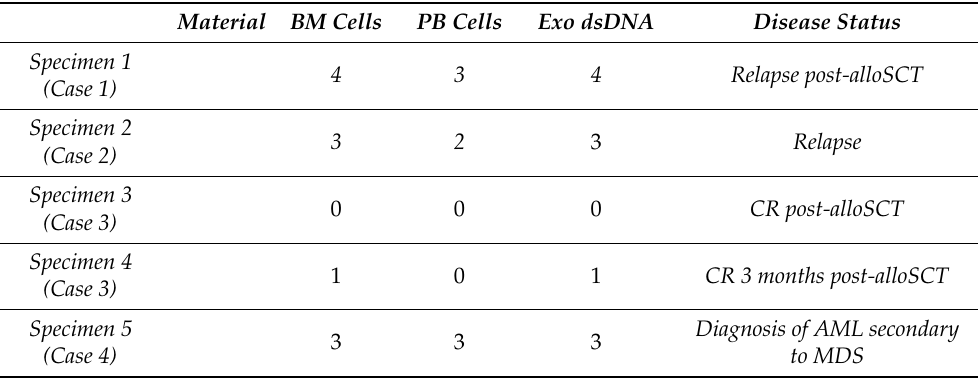
Table 2. Number of mutations detected in bone marrow cells’ DNA, peripheral blood cells’ DNA and circulating exosomes’ DNA in all the considered time